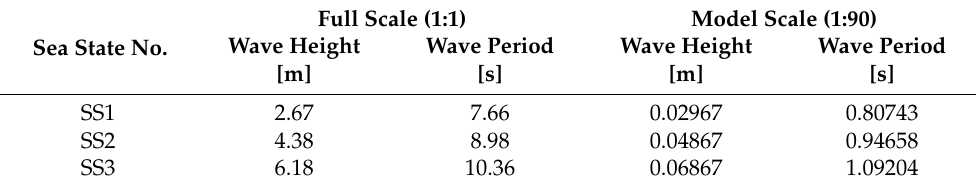
Table 9. LC3 and LC4, Irregular wave conditions for model